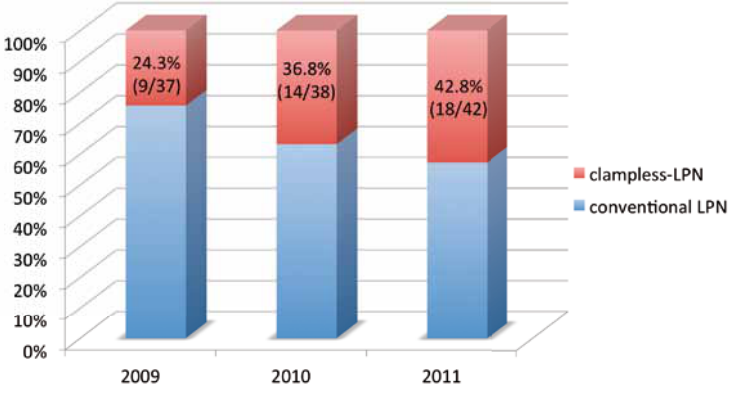
Figure 1 - Histogram showing the annual rate of choice of clampless laparoscopic partial nephrectomy (LPN) with respect to the overall annual number of LPN procedures performed (annual absolute number of procedures is reported in brackets). In Red color: clampless LPN; in Blue color: conventional